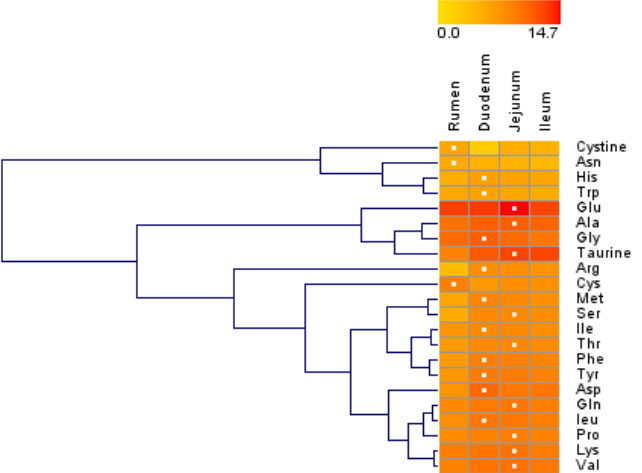
Figure 1. Hierarchical clustering of amino acid concentrations in tissue harvested from the rumen, duodenum, jejunum, and ileum of lactating Holstein cows ( n = 8/group). Dendrograms allow the visualization of clusters of similarity in concentration patterns (links denoted by the lines at the left side of the picture). Concentration levels are denoted by shades of yellow and red according to the log2-transformed least-squares mean. Red intensity denotes a high concentration and yellow intensity a low concentration. White dots denote the highest concentration of an amino acid in a given tissue.